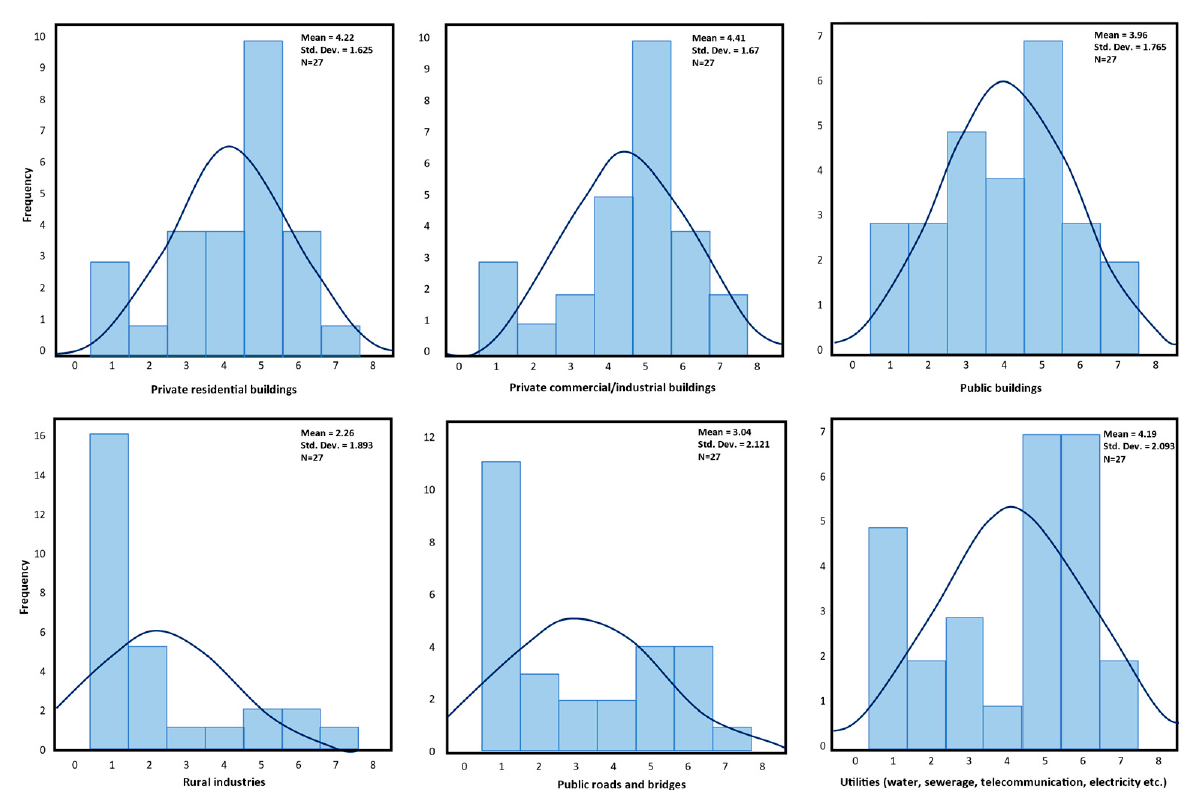
Figure 5. Company priorities for DRM in private residential buildings, commercial/industrial buildings, public buildings, rural industries, public roads and bridges, and utilities.